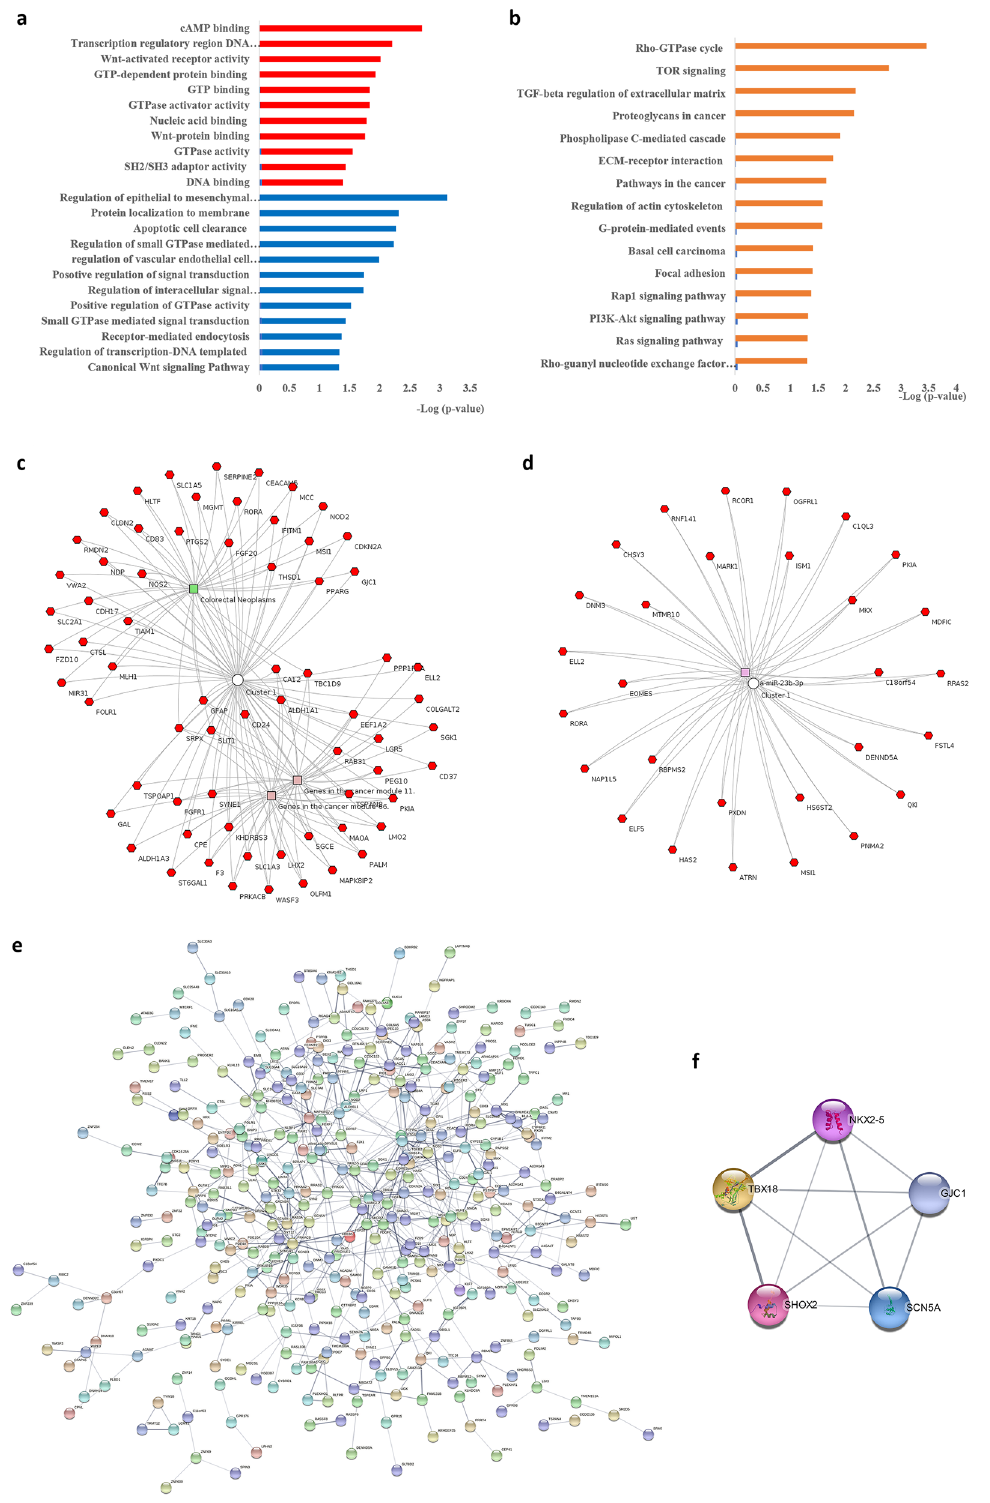
Figure 4. Functional enrichment analysis. ( a ) GO analysis of differentially expressed genes (DEGs) based on the molecular function (Red) and biological process (Blue). ( b ) KEGG pathway analysis of DEGs. ( c ) Functional enrichment analysis by Toppcluster. ( d ) Cluster of miR-23b and its target DEGs. ( e) Protein–protein interaction network of DEGs. ( f ). One functional model identified from the PPI network by